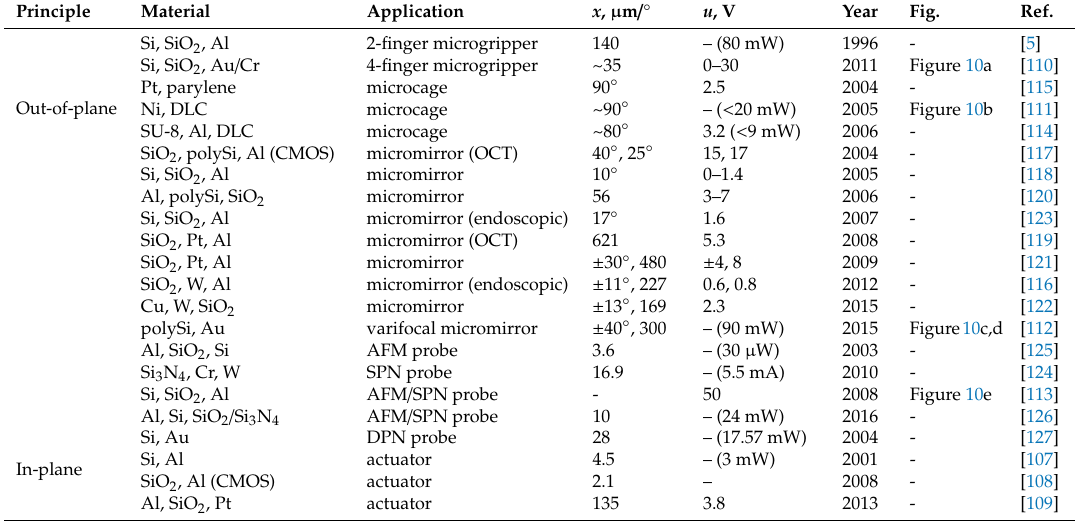
Table 3. Summary of a typical application of bimorph actuators ( x —maximum displacement demonstrated, u —corresponding driving